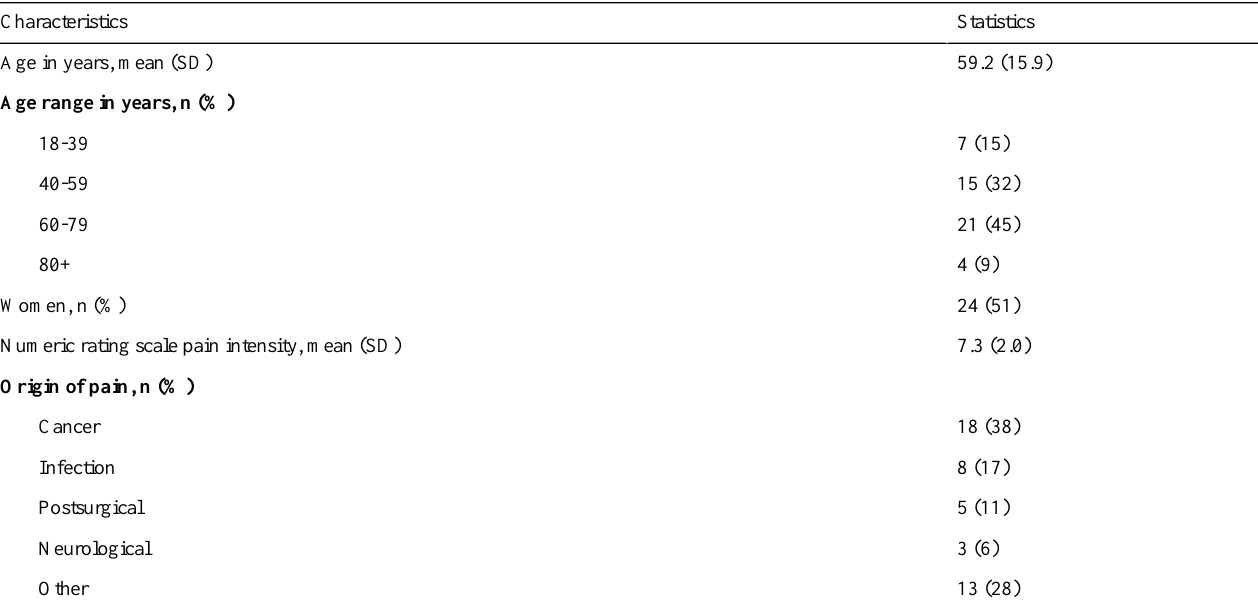
Table 1. Demographics of our study population.